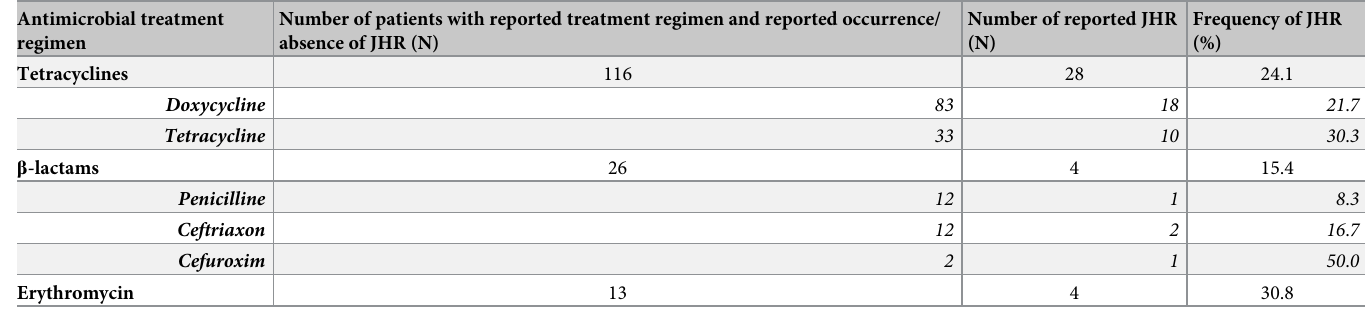
Table 7. Treatment specific frequency of JHR in TBRF (n = 65 studies). Number of patients with reported treatment regimen and reported occurrence/ absence of JHR (N)